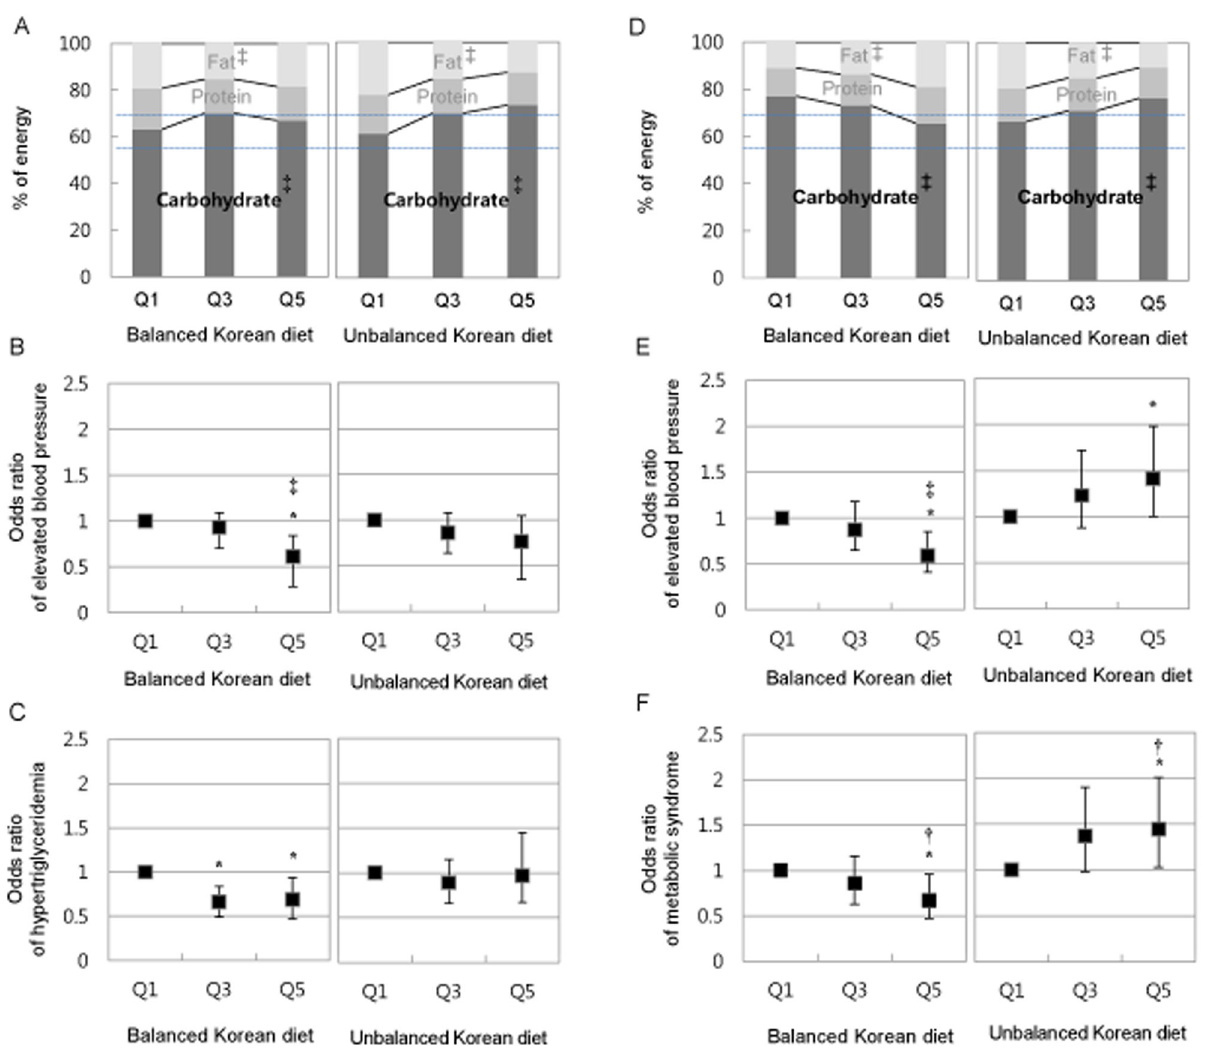
Figure 1. Metabolic syndrome risk and macronutrient composition of balanced Korean diet and unbalanced Korean diet. A and D: Macronutrient composition by quintiles (Q1: lowest, Q3: middle, Q5: highest; Q3 and Q5 was calculated on the base of Q1); % of energy is the percentage of energy obtained from carbohydrate, protein and fat; A dotted line is recommended intake of carbohydrate for Korean; ‡, p for trend <0.001. B and E: Multivariate OR and 95% CI (bar) of elevated blood pressure; *, Significant odd ratio, ‡, p for trend <0.001; Adjusted for age, smoking, alcohol and physical activity. C and F. Multivariate OR and 95% CI (bar) of hypertriglyceridemia for men and metabolic syndrome for women; *, Significant odd ratio, †, p for trend < 0.05; Adjusted for age, smoking, alcohol and physical